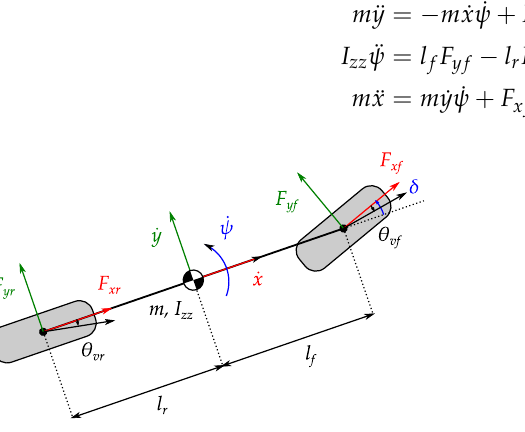
Figure 2. The 3-DOF bicycle CEV